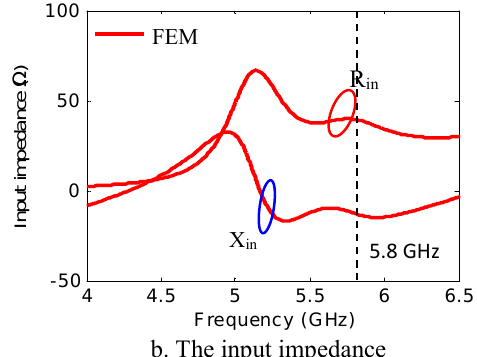
Fig.6. The reflection coefficient and the input impedance of the circularly polarized DRA element mounted on a cylindrical ground plane in the presence of the reader device and human hand model. Figure 7 exhibits the simulated AR in the direction of the main beam versus frequency. The 3-dB AR bandwidth is 170 MHz or 3 % (from 5.68 GHz to 5.85 GHz) relative to the resonance frequency. The antenna has gain of 7.62 dB at 5.8 GHz (compared with 5 dB in free space). The gain is increased due to the dielectric body of the reader device which works as a superstrate layer mounted on the DRA antenna. The far-field radiation patterns of both E L and E R field component s for the designed antenna at resonant frequency 5.8 GHz are shown in Fig.8. The front to back ratio is 15 .5 dB. The presences of the reader device and human hand model have nearly little effect on the radiation characteristics of the DRA antenna as they are located in the back direction of the antenna.